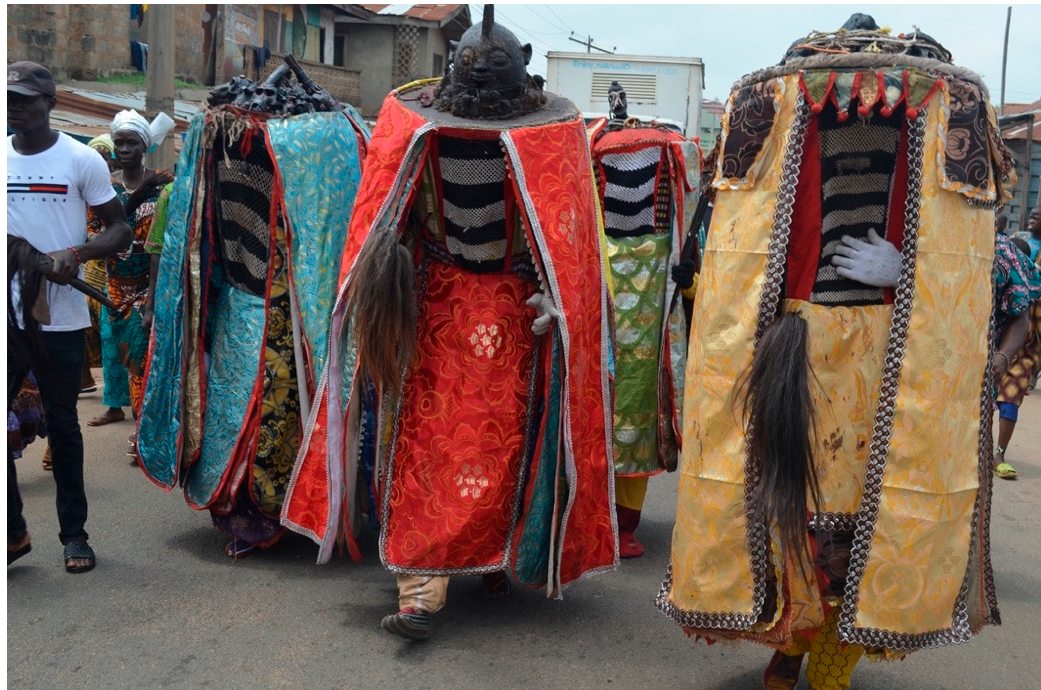
Figure 9. Egúngún masquerade in the Nigerian city of Oyo. Photograph by Akande Abiodun. Figure 9. Eg ú ng ú n masquerade in the Nigerian city of Oyo. Photograph by Akande